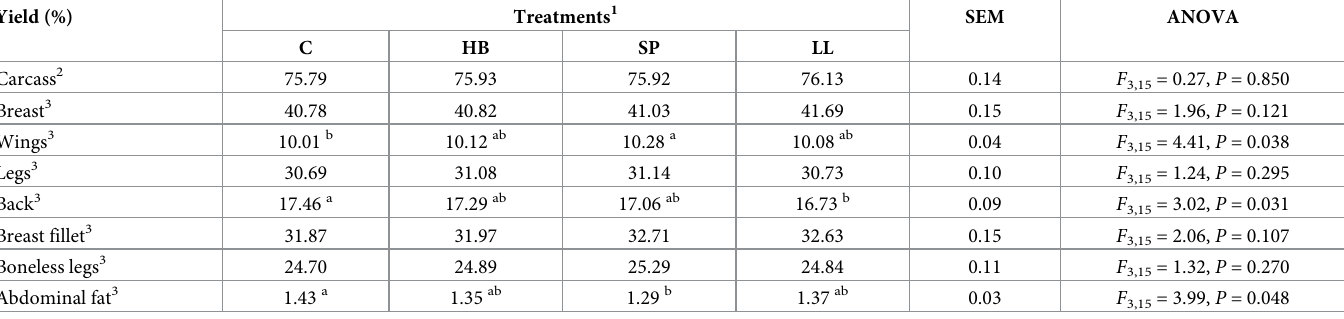
Discussion This is the first study to assess the association between environmental enrichments and sub- clinical spondylolisthesis prevalences. Here we assessed three enrichments that allow broiler chickens to perform natural behavior, reduce subclinical spondylolisthesis prevalence, and maintain performance and yield. The current study showed that access to step platforms and Table 3. Yield (mean % ± SEM) of carcass, breast, wings, legs, back, breast fillet, boneless legs, and abdominal fat of broiler chickens slaughtered at day 43 of age, n = 16. Yield